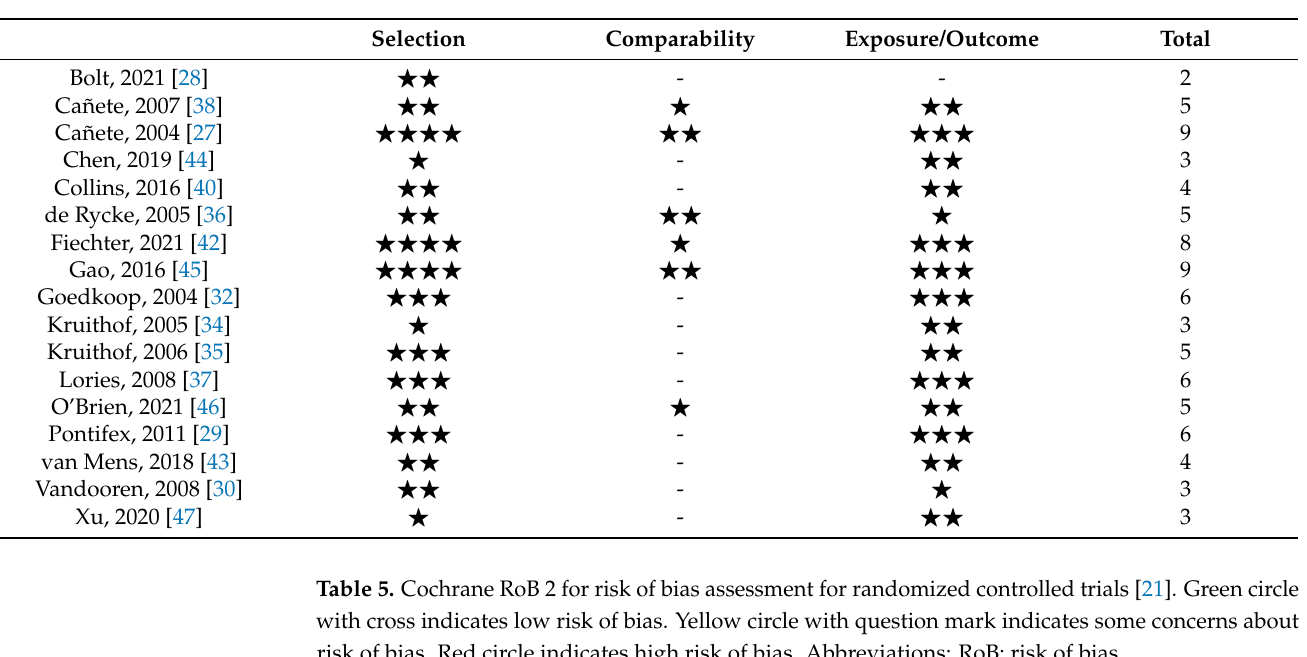
Table 4. Newcastle–Ottawa scale for risk of bias assessment for case–control and cohort studies [20]. Stars identify high quality choices.